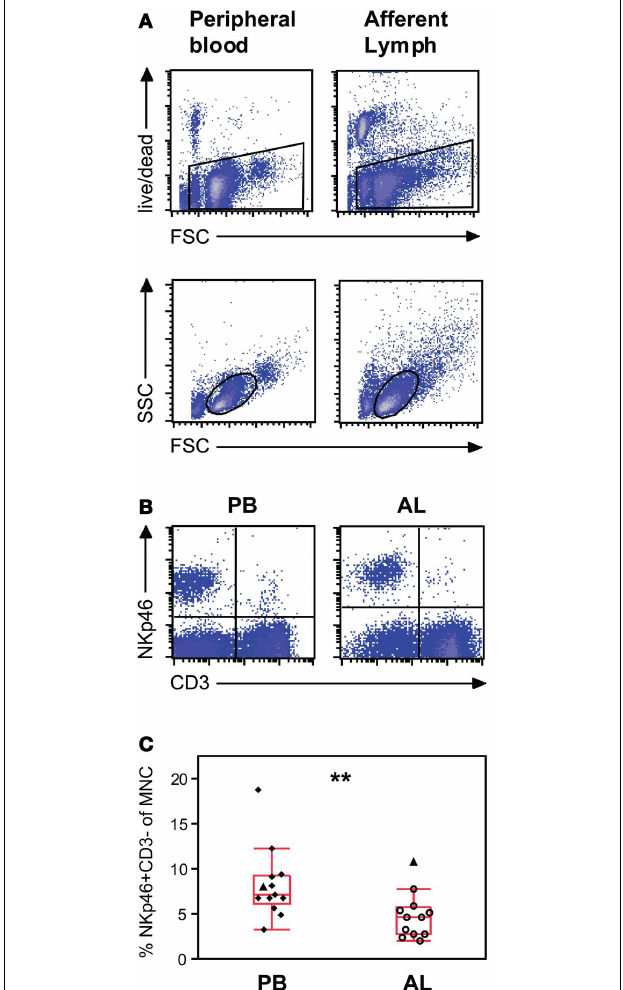
FIGURE 1 | Natural killer (NK) cell distribution in peripheral blood and afferent lymph from calves ex vivo . (A) Gating strategy illustrated by representative density plots. Peripheral blood (PB) mononuclear and afferent lymph (AL) cells were gated on viable cells in a FSC/LIVE/DEAD plot (upper panels) and further gated on mononuclear cells in a FSC/SSC plot (lower panels). (B) Representative density plots showing NKp46 + /CD3 − NK cells in the upper left quartile and (C) distribution of the results showing NK cells as a percentage of mononuclear cells in PB ( n = 13) and AL ( n = 12). Quadrants were based on control staining with secondary antibodies alone. Symbols represent individual animals, where open symbols are Holstein–Friesian and filled symbols are Norwegian Red. Filled triangles identify one paired NR individual. Box plots show median and quartiles, and whiskers indicate data points within the 1.5* (interquartile range). Statistically significant differences between groups indicated as ** p <